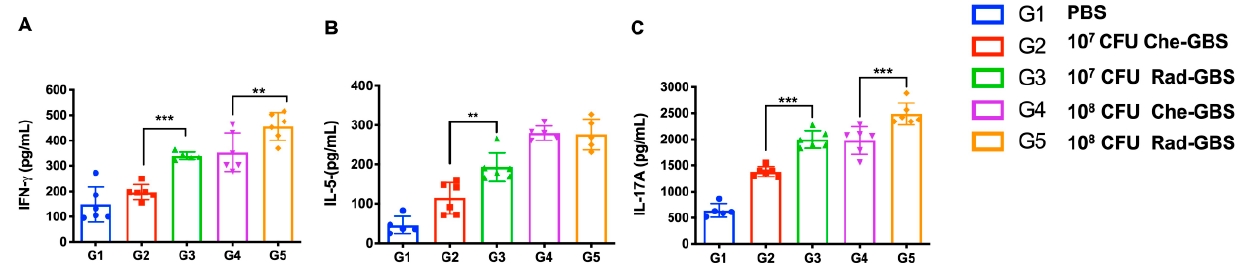
Figure 5. Cytokine production by spleen cells of vaccinated mice. Single-cell suspensions of spleen cells were isolated from mice above and were treated with 20 µg/mL GBS whole-cell lysate for 24 h. Supernatants were collected for the determination of cytokine levels, including ( A ) IFN- γ , ( B ) IL-5, and ( C ) IL-17A in the supernatant. All data are expressed as the mean ± standard deviation of five cell culture supernatant samples and three independent experiments, and p-values were deter- mined by performing an unpaired t test. *** Stands for p < 0.001, ** stands for p < 0.01, and NS for not significant.